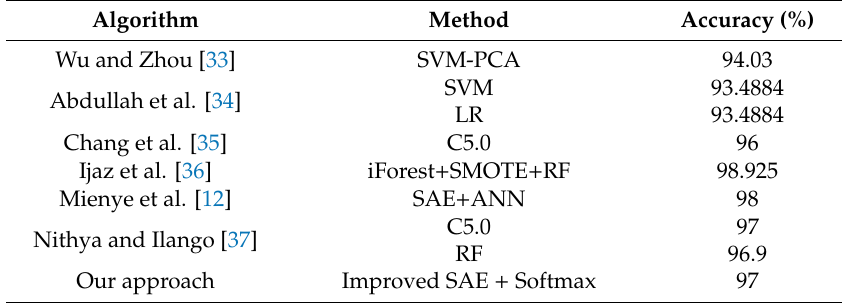
Table 5. Comparison of the proposed method with the recent literature that used the cervical cancer dataset.